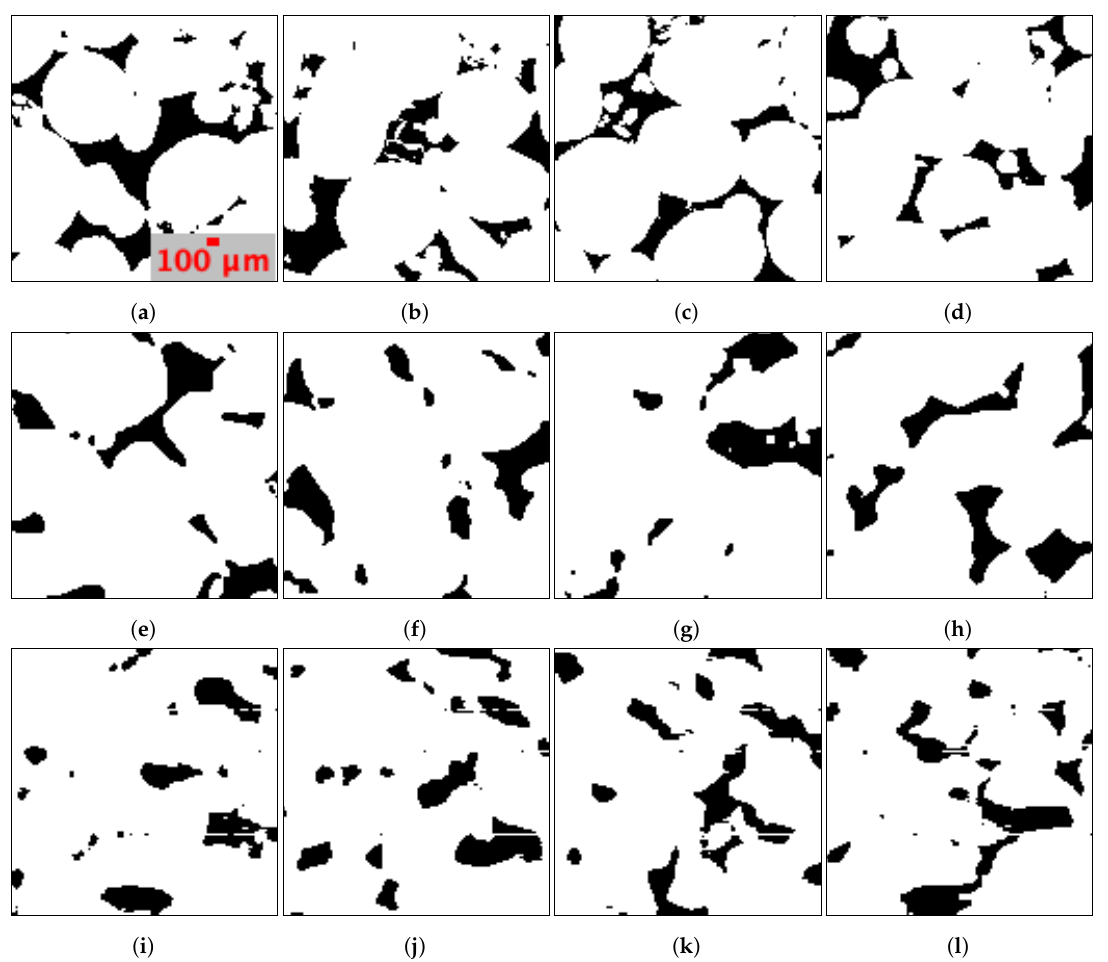
Figure 6. Ketton example images with resolution at 15.2 µ m/voxel: ( a – d ) ground-truth training images in the x − y plane, ( e – h ) binarized synthetic images taken from the x − y plane, and ( i – l ) binarized synthetic images taken from the x − z